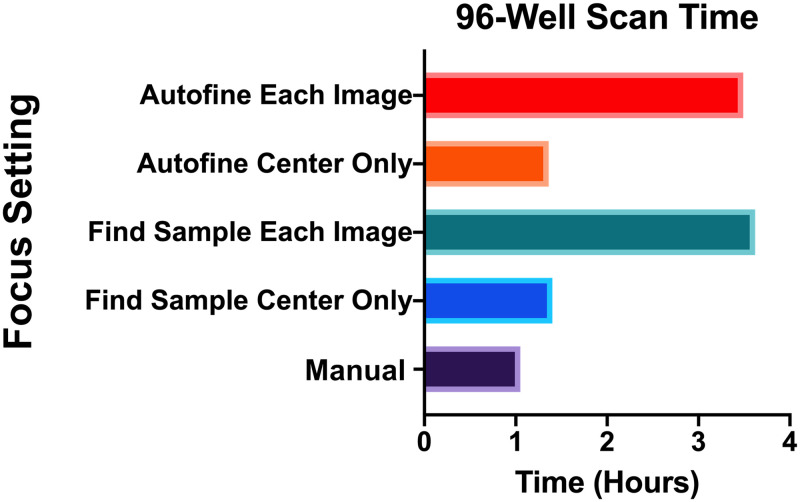
The impact of autofocus on scan time.The time to scan an entire plate varies among the five EVOS focus settings (Autofine each image, Autofine center only, Find sample each image, Find sample center only, and Manual).